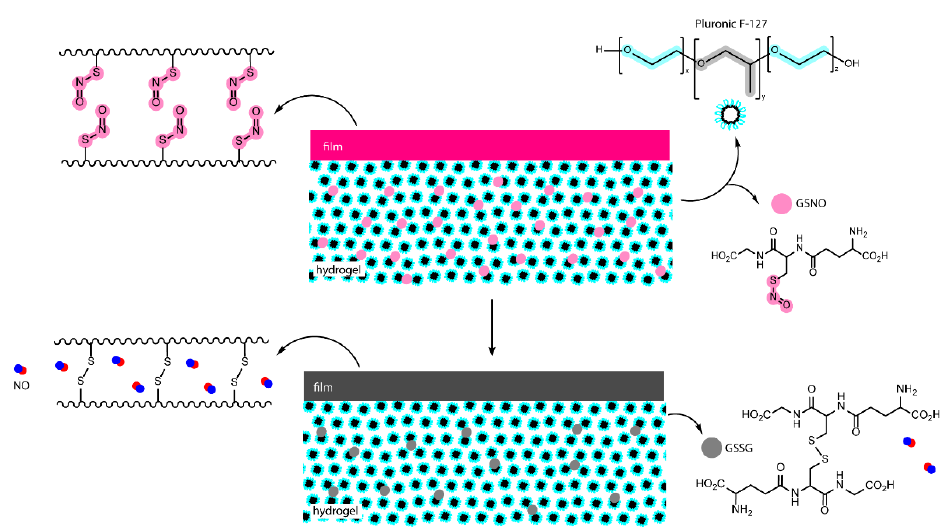
Figure 6. Poly(vinyl alcohol) films modified with SNO groups and GSNO-containing Pluronic F-127 hydrogels. Adapted from ref. [133].